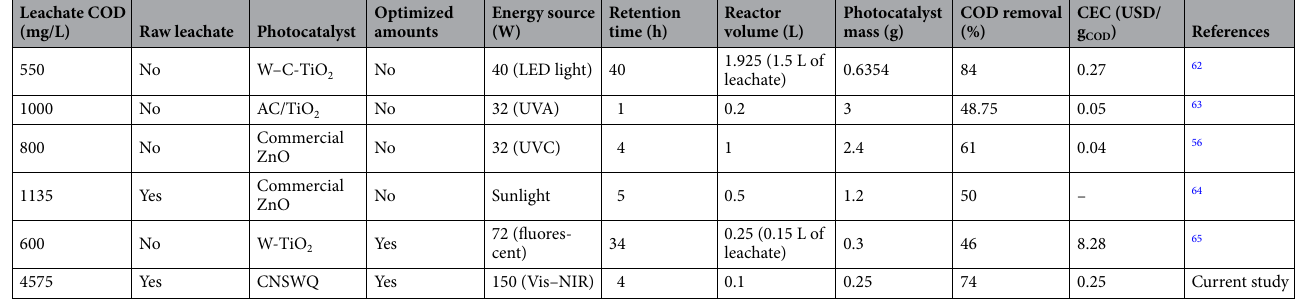
Table 1. Comparison of landfill leachate photodegradation, CEC, and other properties of current work and other